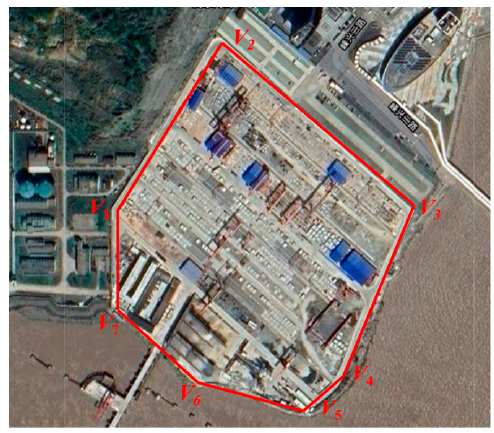
Figure 1. Remote sensing map of detection area 1.